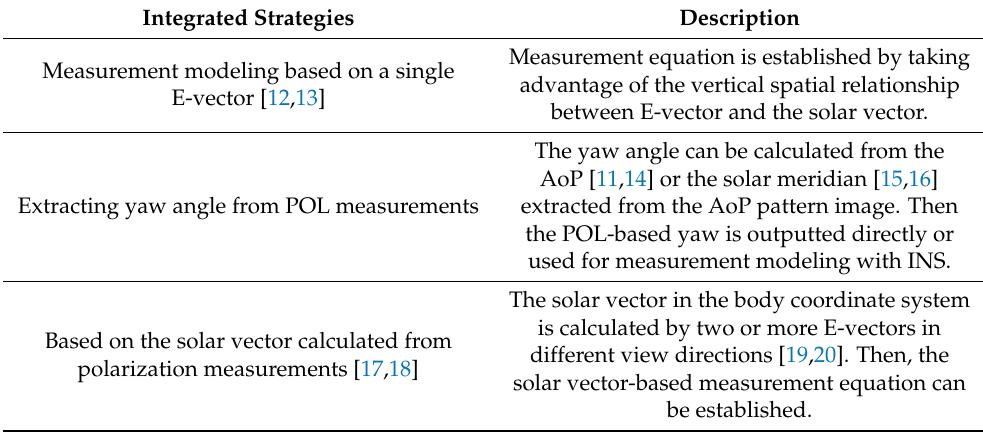
Table 1. A review of current INS/POL integrated navigation strategies. Integrated Strategies Description Measurement modeling based on a